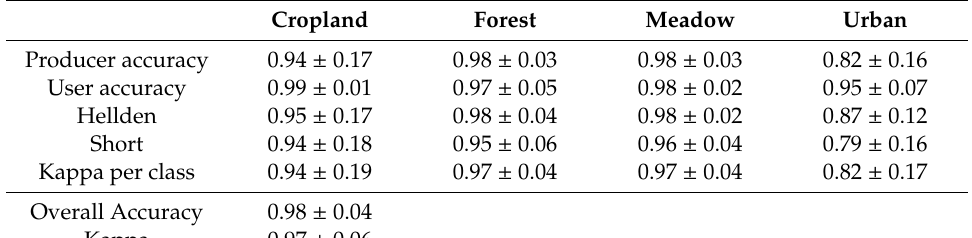
Table 6. Accuracy assessment of four land classes on 26 tiles based on